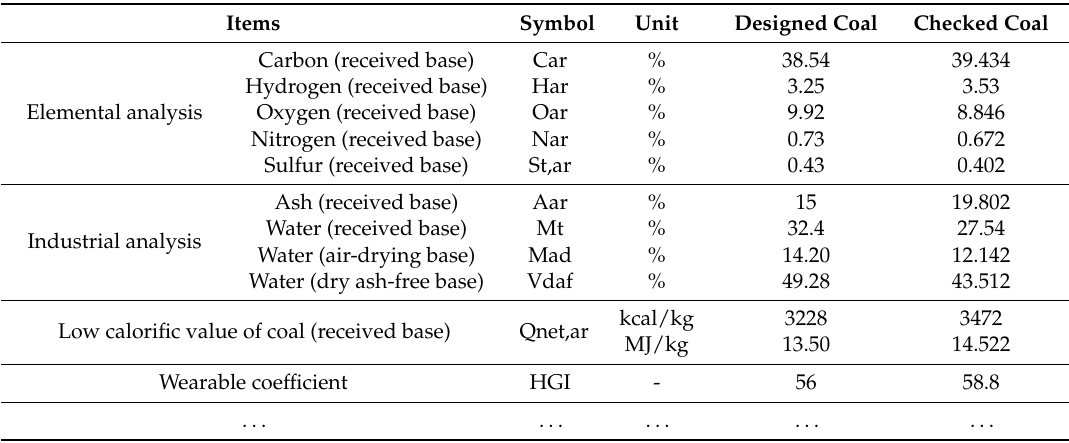
Table A3. Parameters of designed